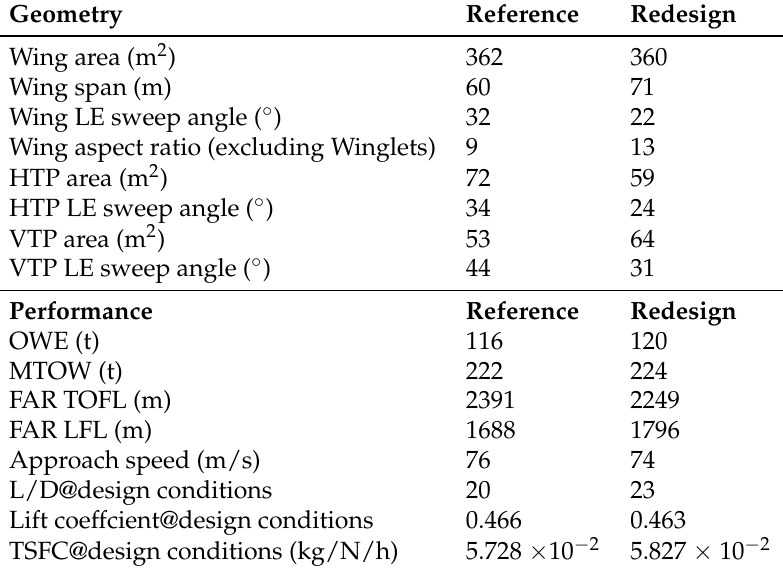
Table 5. Key design parameters for the reference and redesigned aircraft under initial cruise conditions. LE: leading edge; HTP: horizontal tail plane; VTP: vertical tail plane; OWE: operational empty weight; MTOW: maximum take-off weight; TOFL: take-off field length; LFL: landing field